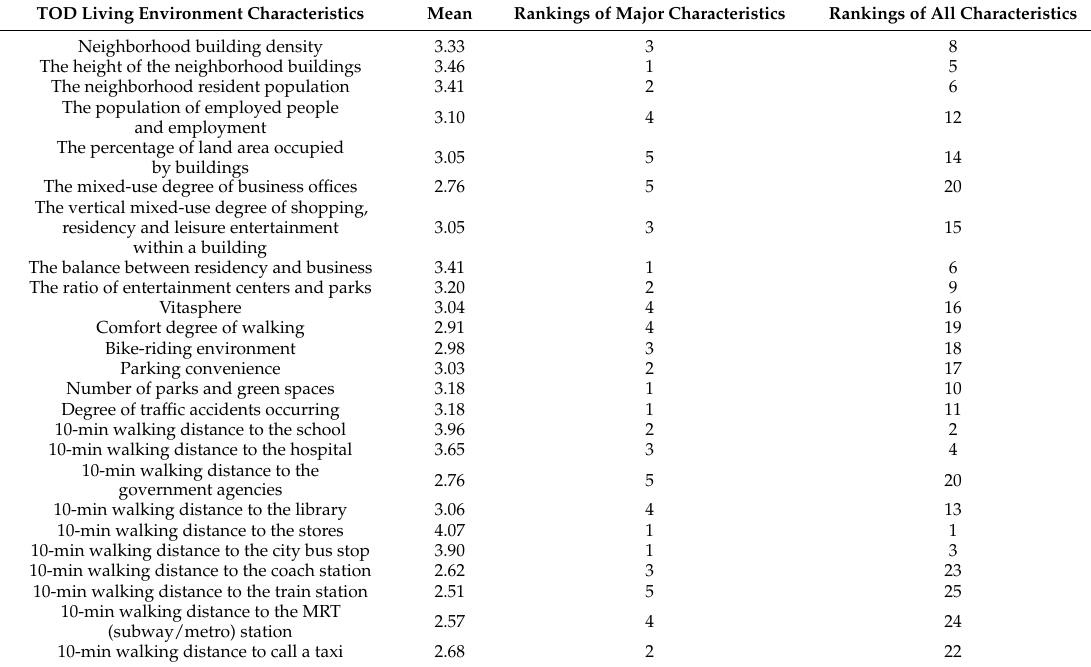
Table 2. Satisfaction descriptive statistics table of 25 TOD living environment characteristics.